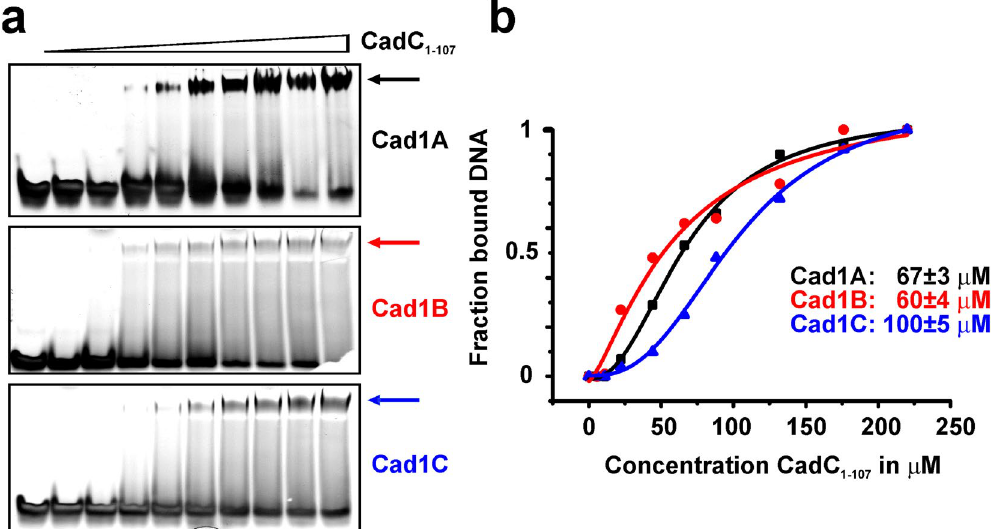
Figure 3. EMSA-based analysis of Cad1 fragments. ( a ) Representative EMSA analysis of fragments Cad1A, B and C when titrated with CadC 1-107 to ten-fold stoichiometric excess. Arrows indicate the complex species. ( b ) Quantification of EMSA experiments in ( a ). Binding constants are given as obtained from a one-site binding event and shown as mean ± standard